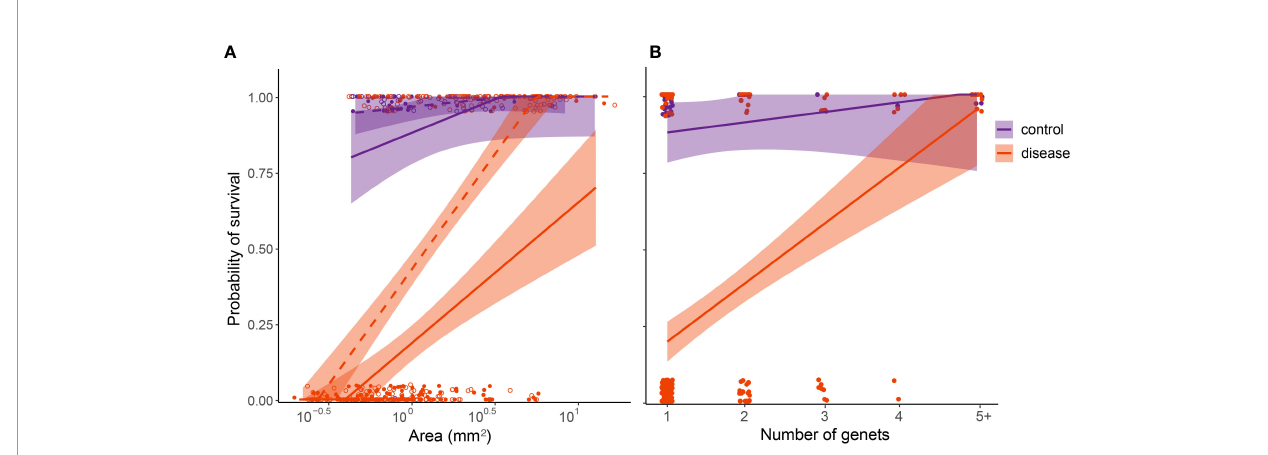
FIGURE 7 | Relative susceptibility of four-month-old C. natans recruits to SCTLD during a 20-day experimental exposure (Exposure 1). Recruits in the control treatment were not exposed to SCTLD, and thus represent the “ background mortality ” level expected for these juvenile corals. (A) ; Survival probability is positively correlated with polyp area. Areal data were log(10) transformed to fi t statistical assumptions. Solid lines and points represent single recruits, while dashed lines and un fi lled points represent members of chimeric groups. (B) ; Survival probability is positively correlated with number of genets/polyps grouped together. Points were jittered to prevent overlap. For both (A, B) , GLMs corrected for binomial survival data were used to fi t the data, and shaded regions show 95% con fi dence